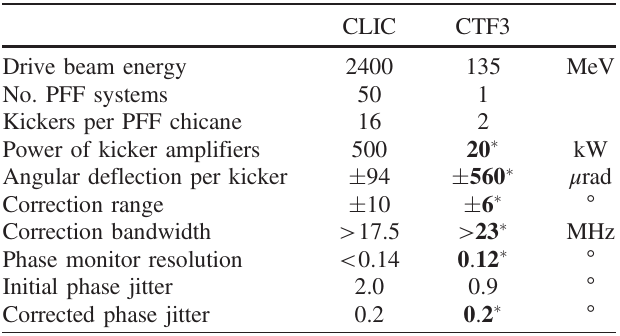
TABLE I. Requirements for the CLIC PFF system, and the respective CTF3 parameters; performance achieved with the prototype system is indicated by *